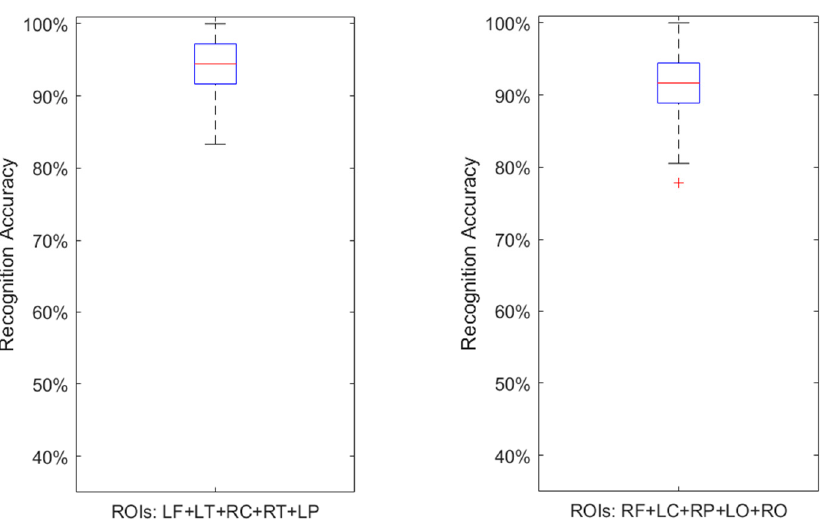
Figure 4. Boxplots for MCR approach using 3-NN. ( Left ): hyper-COH group, mean accuracy 93.83%; ( Right ): hypo-COH group, mean accuracy 91.39%. The red lines indicate the median accuracies.